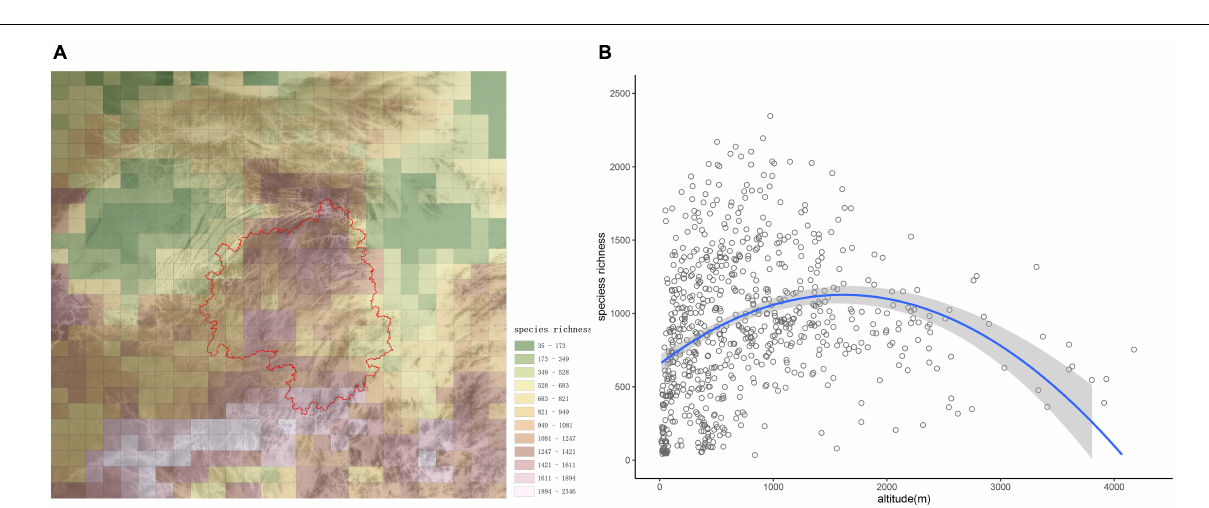
FIGURE 2 | Species distribution patterns in the studied region. (A) α -diversity of woody plant species in the study area, with different colors indicating species richness categories. The base graphic is a topographic map, and the red line delineates Wuling Mountains. (B) Altitudinal patterns of species richness are presented for the study area. The regression equation was y = − 0.0002x 2 + 0.5848x + 654.82 ( p <